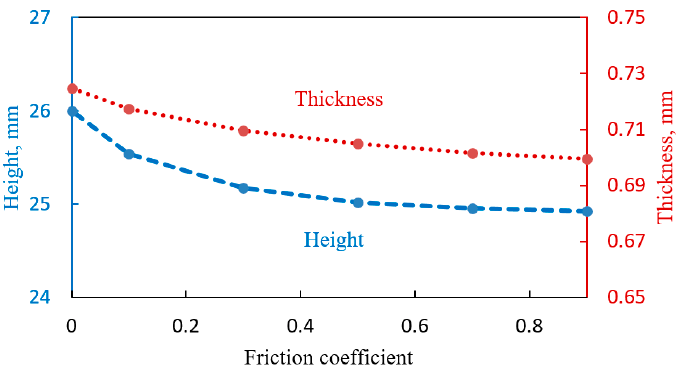
Figure 7. Variations in height and thickness with friction at equal moment of time and pressure regime.